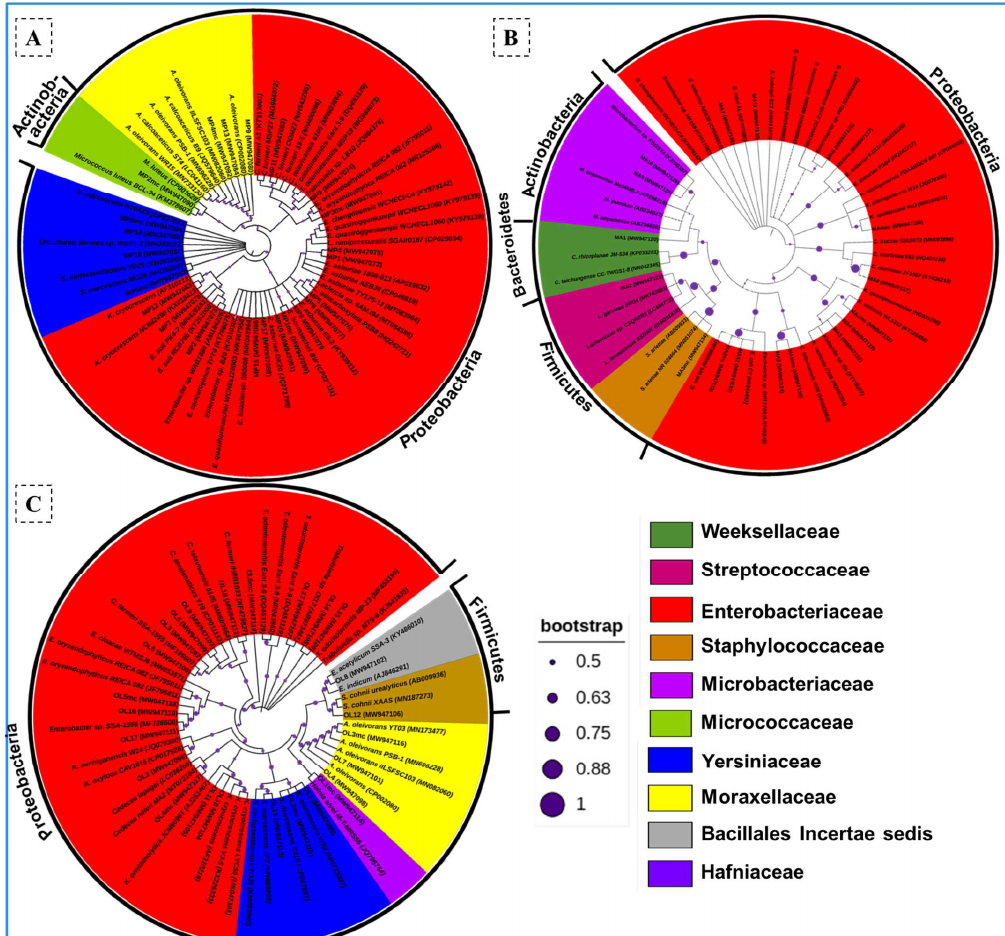
Figure 1. Phylogenetic affiliation of the bacteria isolated from A. pakistanicus ( A ), Macrotermes sp. ( B ), and O. longignathus ( C ) . The filled circles indicate the fraction of bootstrap values based on 500 replicates. The phylogenetic trees were reconstructed by the neighbor-joining method in MEGA X software, showing the relationship of the identified bacteria with closely related species retrieved from the NCBI database. The accession number of each isolate is given in parentheses beside the isolate code.